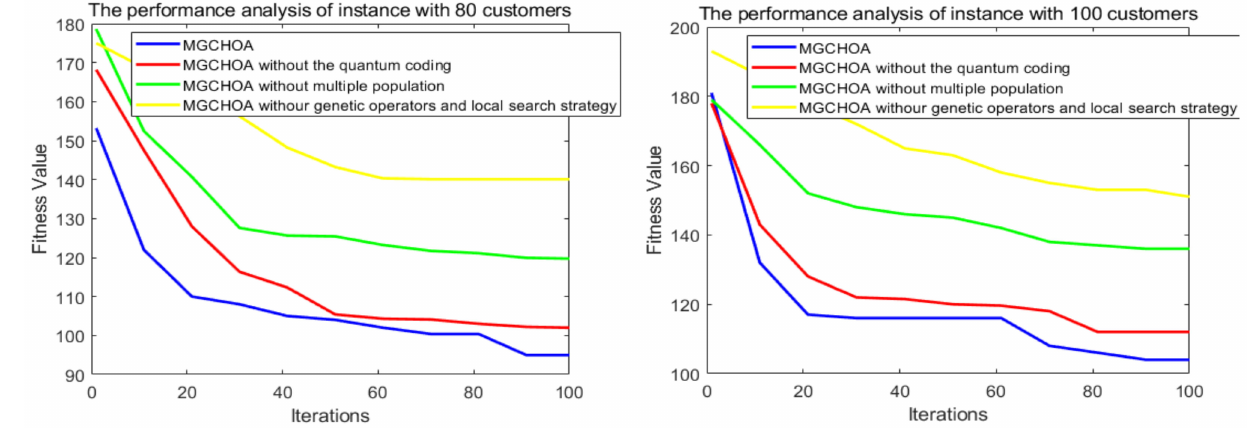
Figure 22. The results of various improved methods on the 80-customer and 100-customer